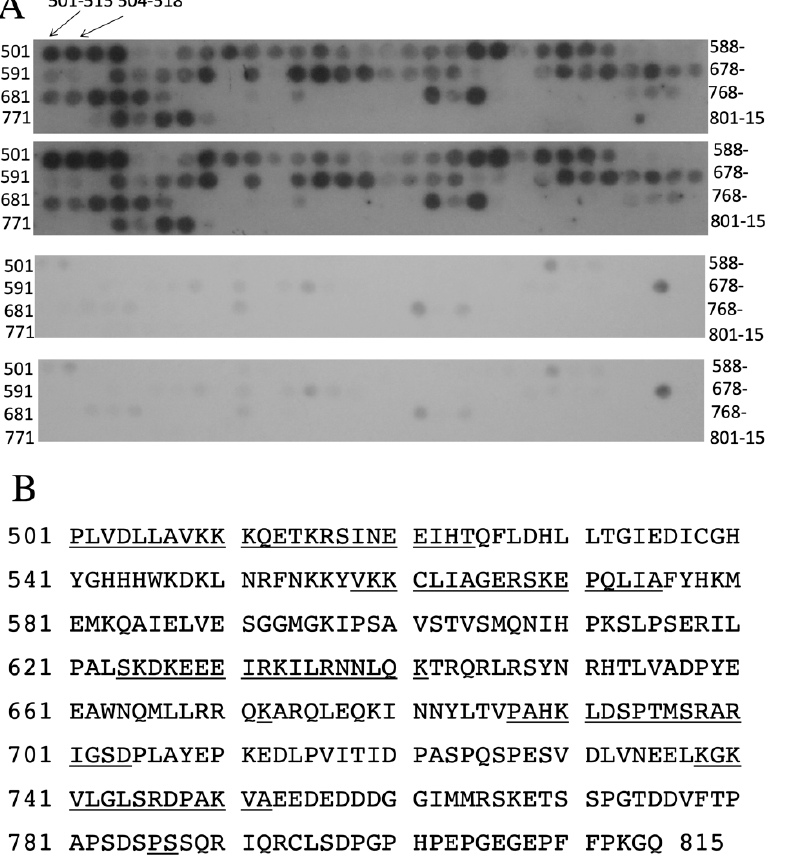
Figure 6. Probing of peptide constructs [39] of amino acids 501–815 of the human NHE1 C-terminus with the peptide of the sequence N-GSD E P E SQGDYKDDDDKG or with the control peptide of the sequence N-GSD A P A SQGDYKDDDDKG. Underlined sequences indicate the amino acids of the 15mer that bound to the probe that bound in larger amounts. Bold amino acids indicate either phosphomimetic replacements (Glu) or Ala for amino acids Ser 785 and Ser 787 . The N-terminal peptide of the peptide array is indicated. Each spot on the array contains a peptide of 15 amino acids in length. The adjacent peptide is shifted by three amino acids as indicated. ( A ) Illustration of results of probing with peptides (in duplicate). Upper two panels are separate IQ-peptide arrays probed with experimental phosphomimetic peptide. Lower two panels are separate IQ-peptide arrays probed with the control peptide which had two Glu residues changed to Ala. ( B ) NHE1 C-terminal amino acids indicating regions of stronger binding to the tagged